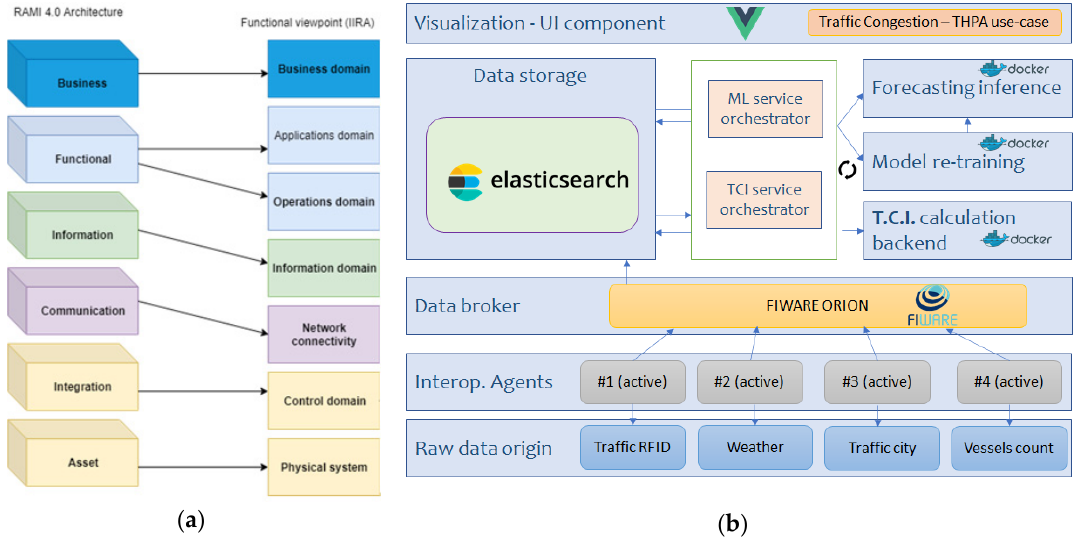
Figure 2. Architecture of the proposed framework: ( a ) IoT layered reference architecture RAMI4.0 and IIRA—image extracted from [79]; ( b ) Modules and technologies of the framework. The figures are aligned to reflect the mapping reference layer - component.